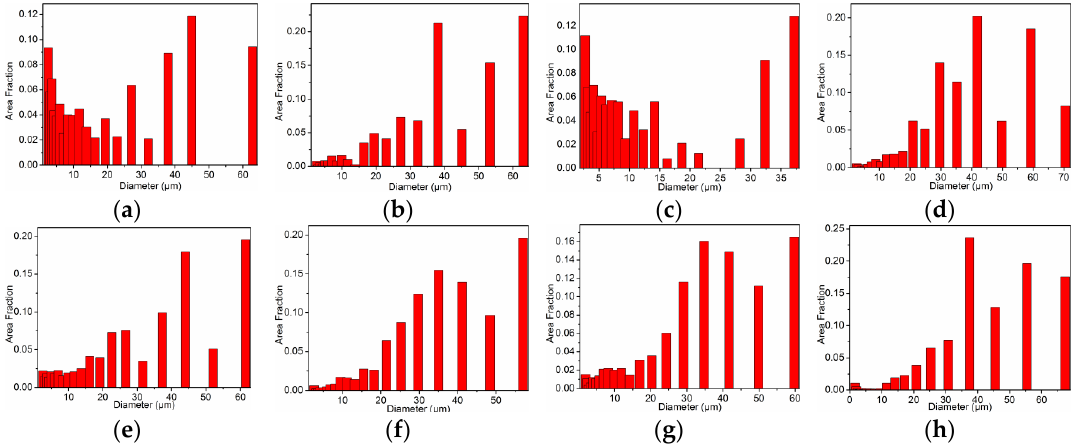
Figure 5. Variations of gain size in the samples after hot-compressing with different conditions: ( a ) 340 °C, 1 s −1 ; ( b ) 340 °C, 0.001 s −1 ; ( c ) 380 °C, 1 s −1 ; ( d ) 380 °C, 0.001 s −1 ; ( e ) 420 °C, 1 s −1 ; ( f ) 420 °C, 0.001 s −1 ; ( g ) 460 °C, 1 s −1 ; and ( h ) 460 °C, 0.001 s −1 .